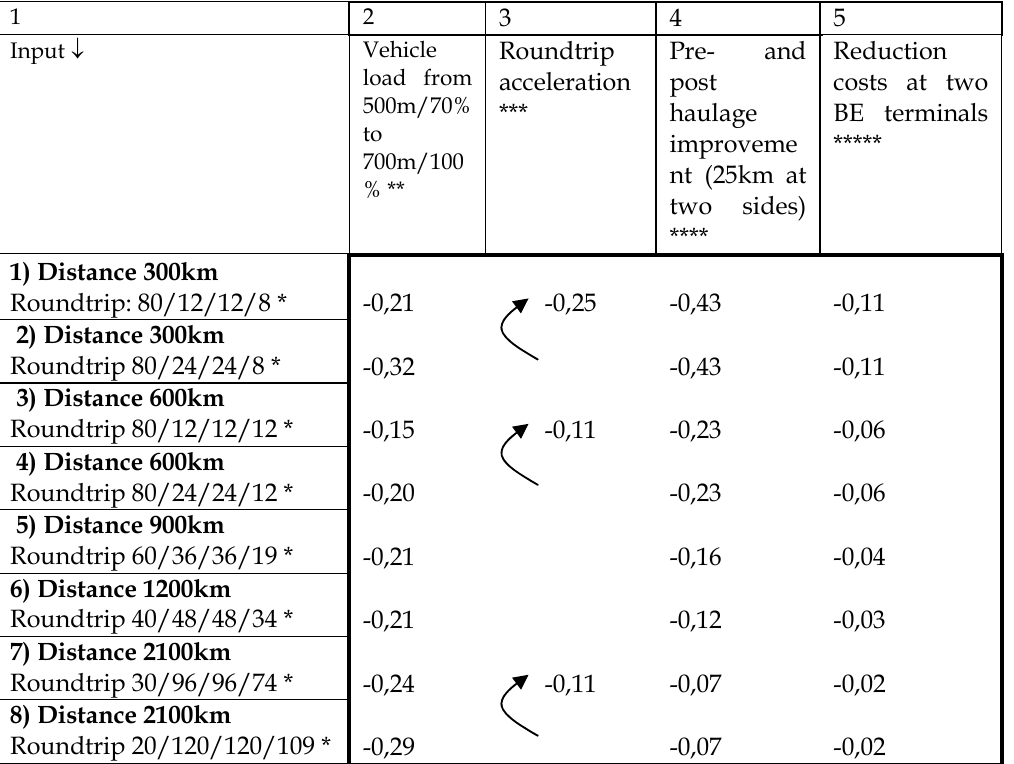
Table 2. Indications of cost reductions (Euro/LU-km) induced by measure